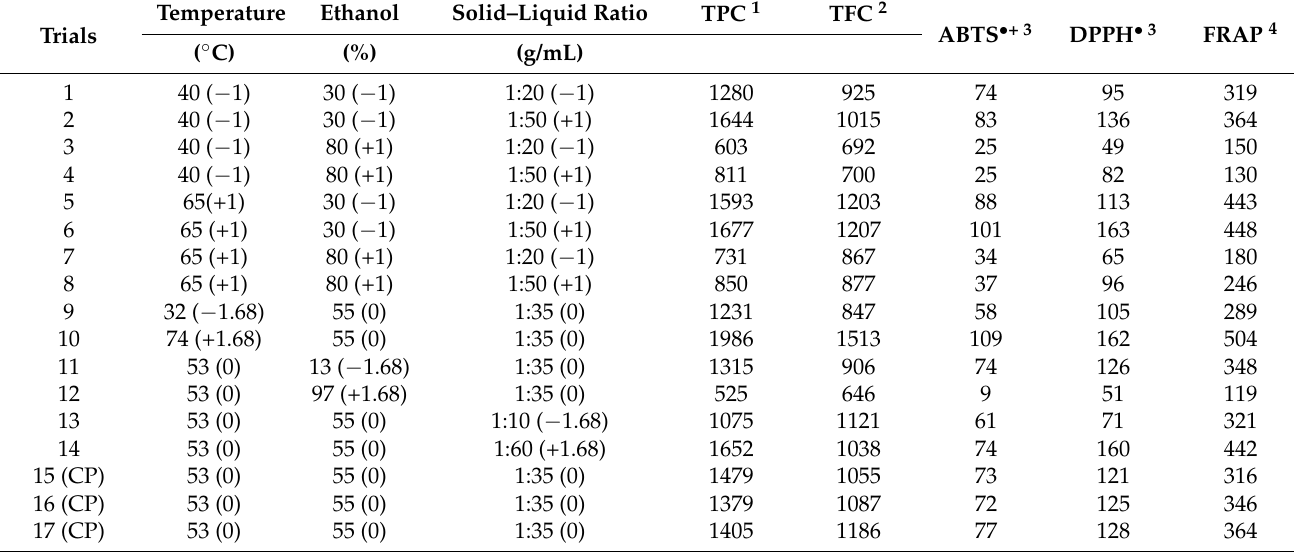
Table 1. Real and coded values of the independent variables employed to recover the bioactive com- pounds from umbu peels and total phenolic (TPC) and flavonoids (TFC) compounds and antioxidant capacity values of the